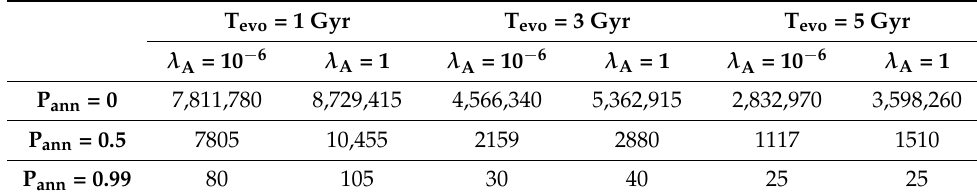
Figure 1. Spatial–temporal profiles for Z ETI ( A ) T evo = 1 Gyr, ( B ) T evo = 3 Gyrs, ( C ) T evo = 5 Gyrs; ( I ) P ann = 0, ( II ) P ann = 0.5, ( III ) P ann = 0.99, over 20 Gyrs. Each vertical individual panel corresponds to a specific value of λ A , as shown in the title above. The white star marks the current location of our sun at 8 kpc, and 13.5 Gyrs, and the white dashed line represents our current time line of 13.5 Gyrs. Table 1. Each numerical value represents the maximum Z ETI of its spatial–temporal profile in Figure